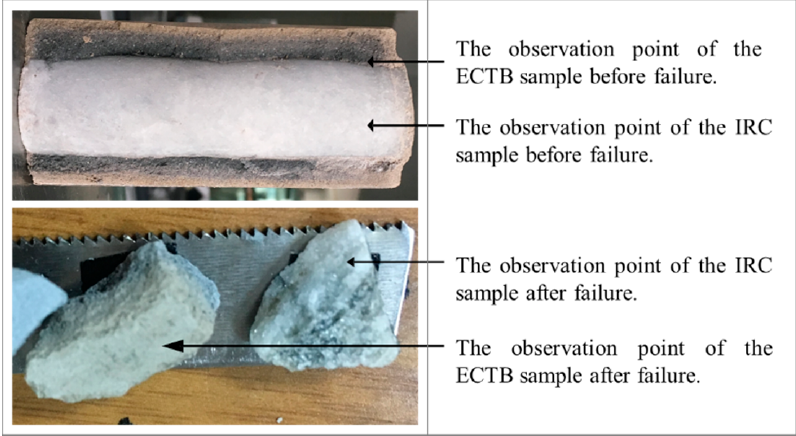
Figure 15. The observation point of the ECTB and IRC before and after failure by the TSC test.